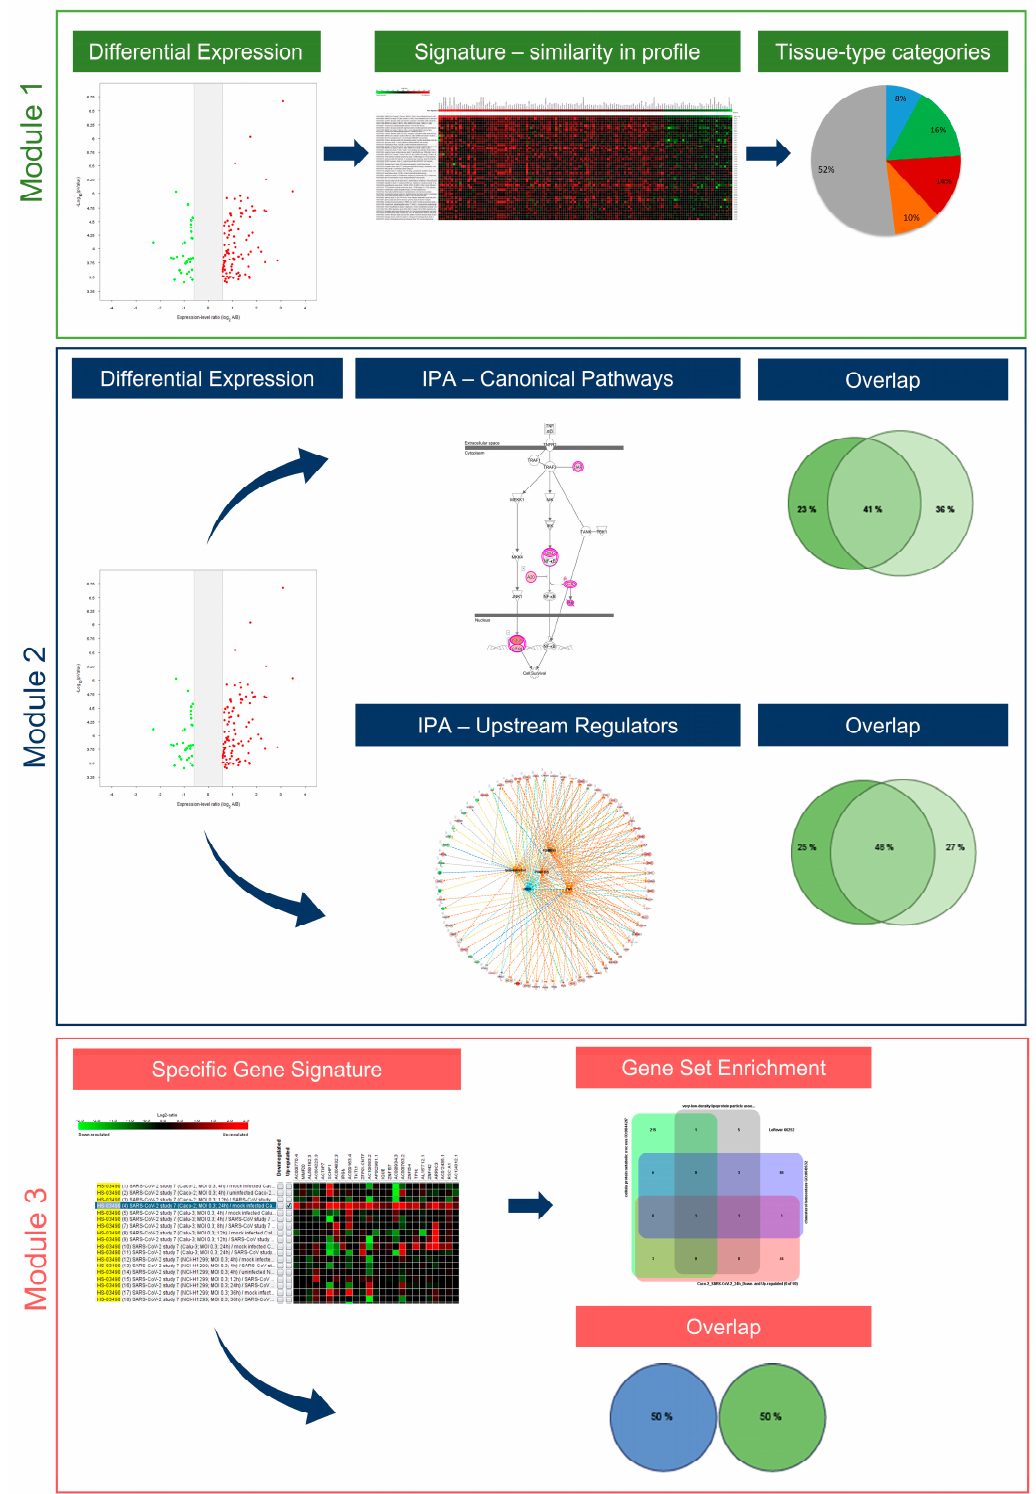
Figure 3. The UNCOVIDING approach and the individual analytical modules. The figure illustrates the 3-modular algorithm on the basis of the compendium-wide analysis of transcriptomic